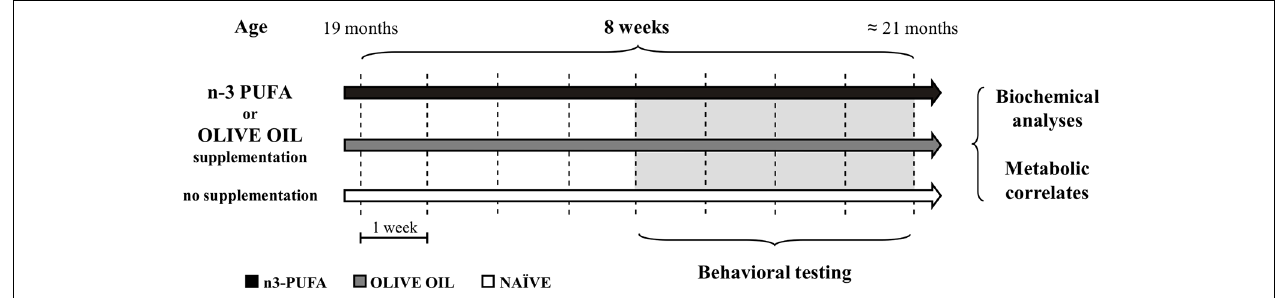
FIGURE 1 | Global timing of the experimental procedure. Experimental groups of aged mice (n-3 PUFA, OLIVE OIL, and NAÏVE), type of dietary supplementation (duration: 8 weeks), behavioral testing (EPM, Elevated Plus Maze; SYM, Spatial Y-Maze; MWM, Morris Water Maze; ORT, Object Recognition Maze; CFC,